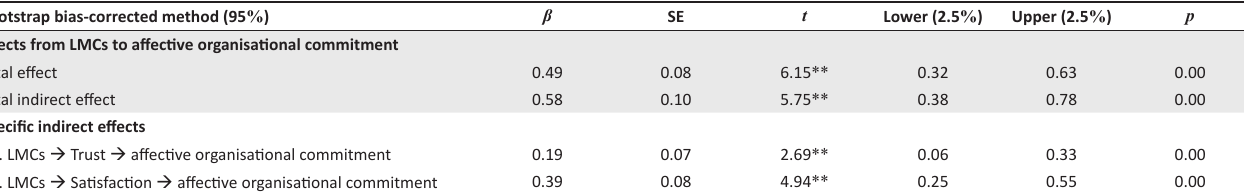
FIGURE 2: Structural equation model path results. TABLE 4: A mediation analysis. Bootstrap bias-corrected method (95 % )